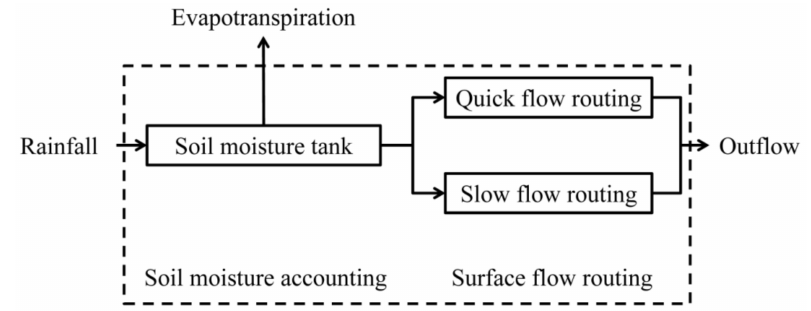
Figure 1. Configuration of